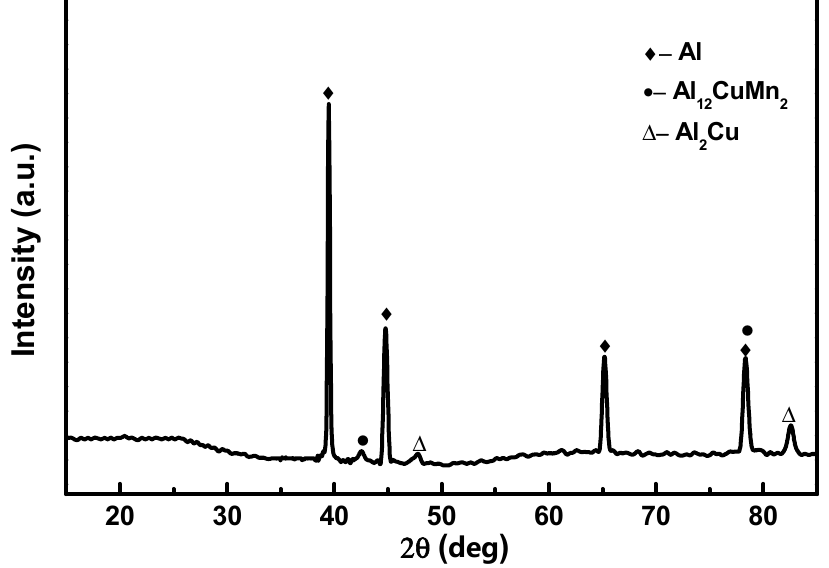
Figure 6. XRD spectrum of squeeze-cast ZL205A.